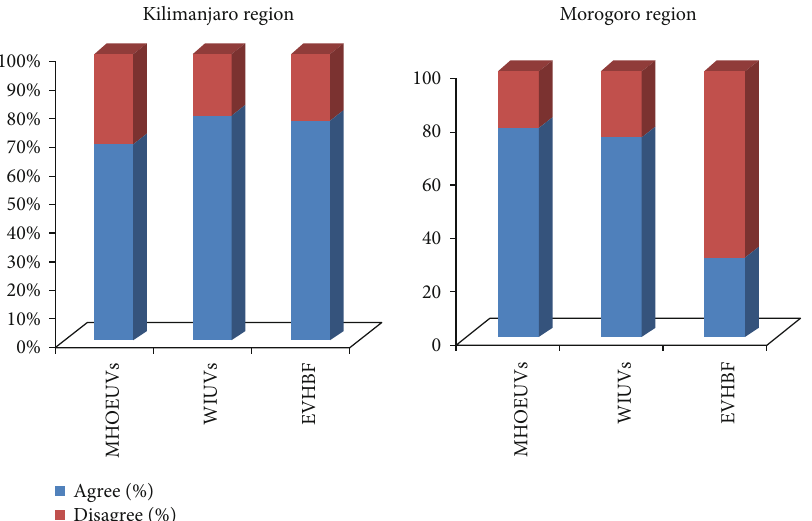
Figure 5: Interests and preferences of the UVs. MHOEUVs: members of the household often eat UVs; WIUVs: we are interested with the UVs; EVHBF: exotic vegetables have better features/bene fi ts.